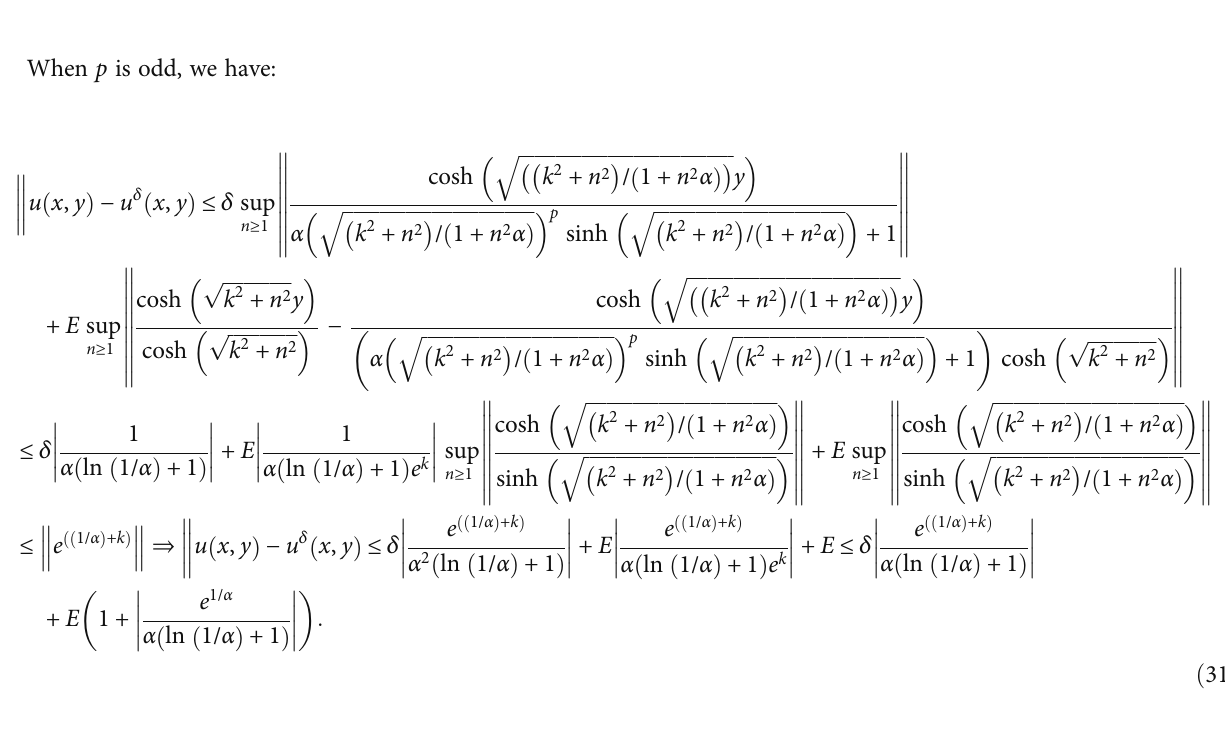
ffiffiffiffiffiffiffiffiffiffiffiffiffiffi p k 2 + n 2 ffiffiffiffiffiffiffiffiffiffiffiffiffiffi ffiffiffiffiffiffiffiffiffi p ≤ e − k 2 + n 2